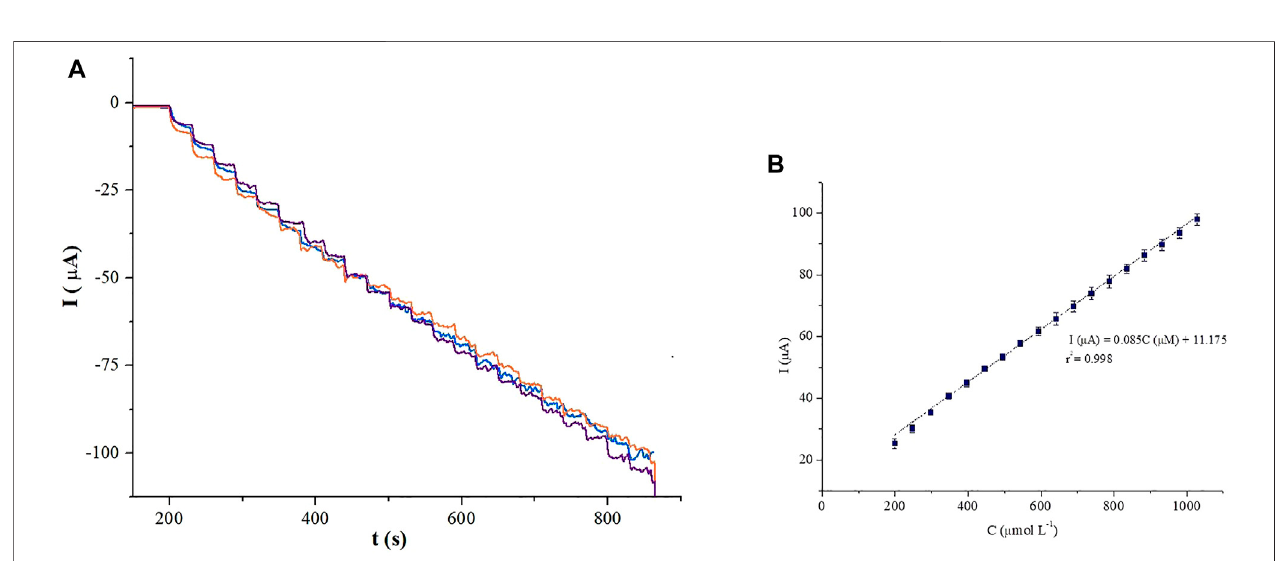
FIGURE 13 | Chronoamperometric detection of H 2 O 2 at the PB-fCNT/TiO 2 .ZrO 2 (36)500 ° C.20/GC electrode, in PBS (pH 3) solution (A) and its (B) calibration plot. Working potential of − 0.03 V vs. Ag/AgCl.